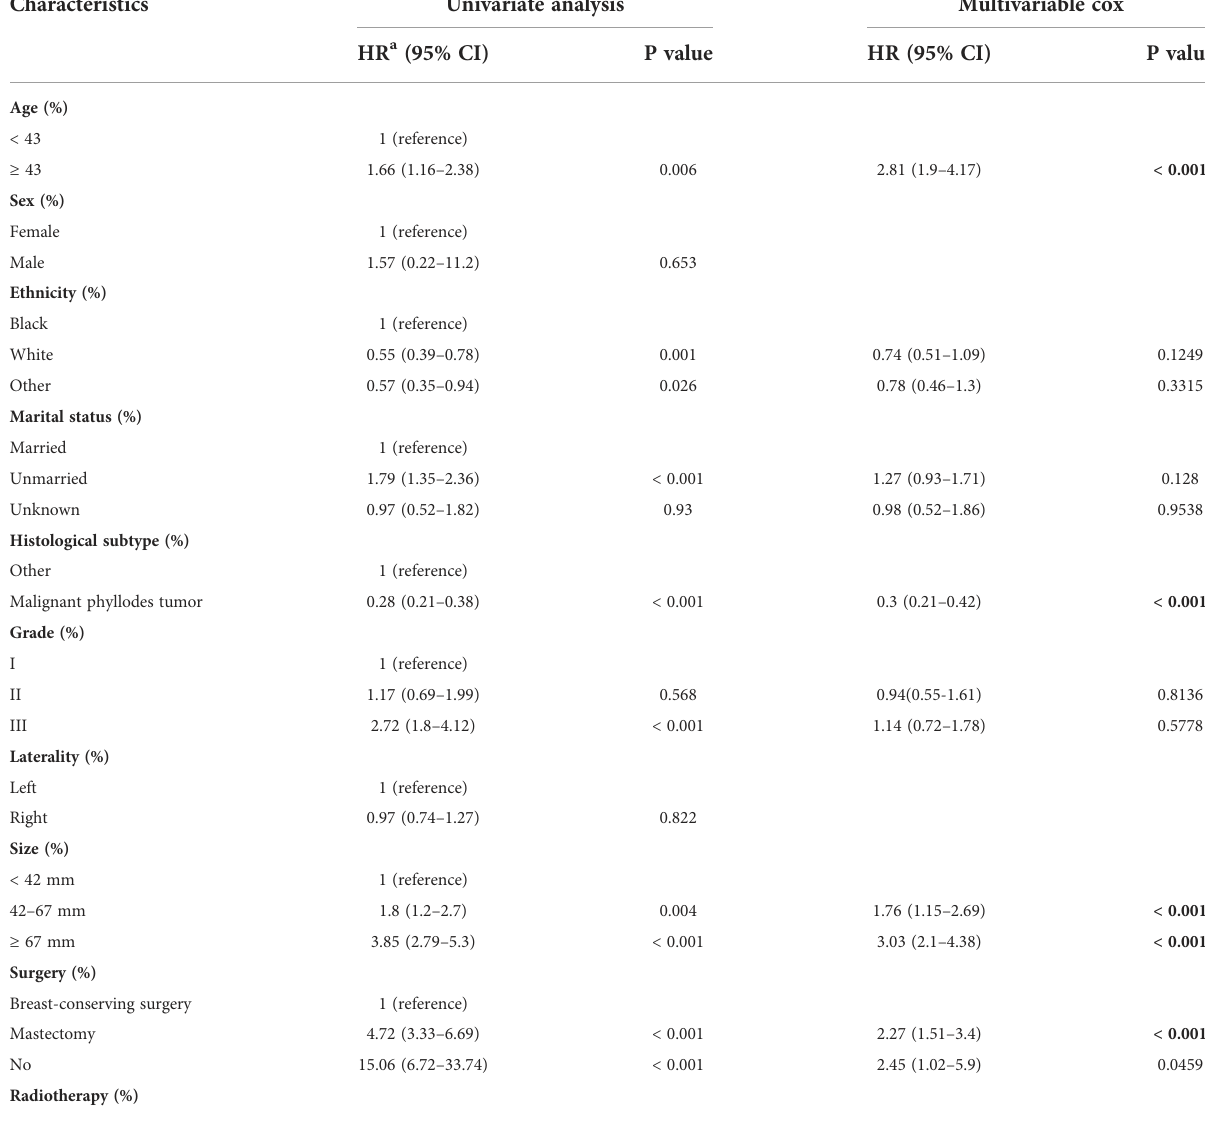
TABLE 2 Analysis of overall survival using univariate and multivariate Cox analysis in the training set.